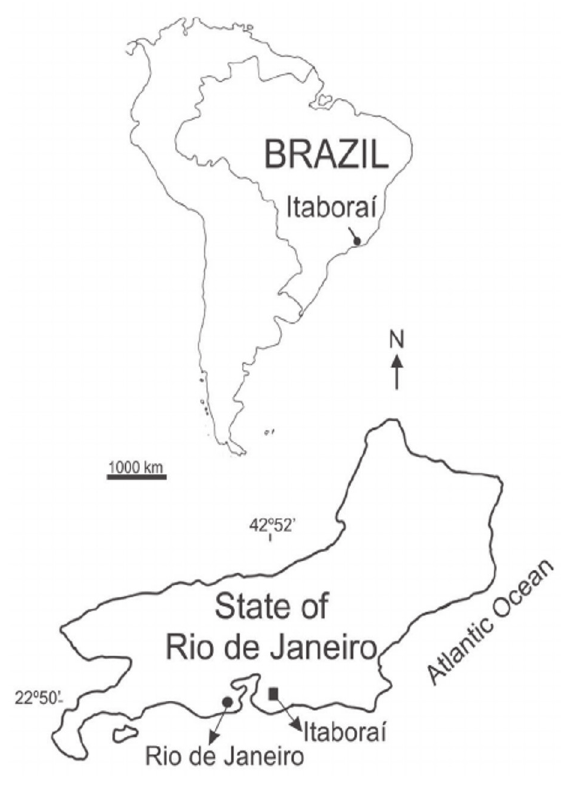
Figure 1 - Location map showing the region and coordinates of the Itaboraí Basin, São José de Itaboraí, rio de Janeiro, Brazil (22º45’9.9144’’S, 42º51’53.5536’’W). Figure adapted from the figure 1 (p. 106) from Oliveira and Goin